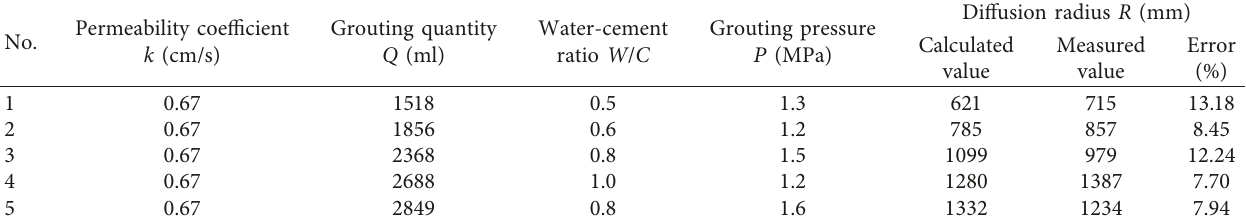
Table 4: Comparison between the calculated value and the measured